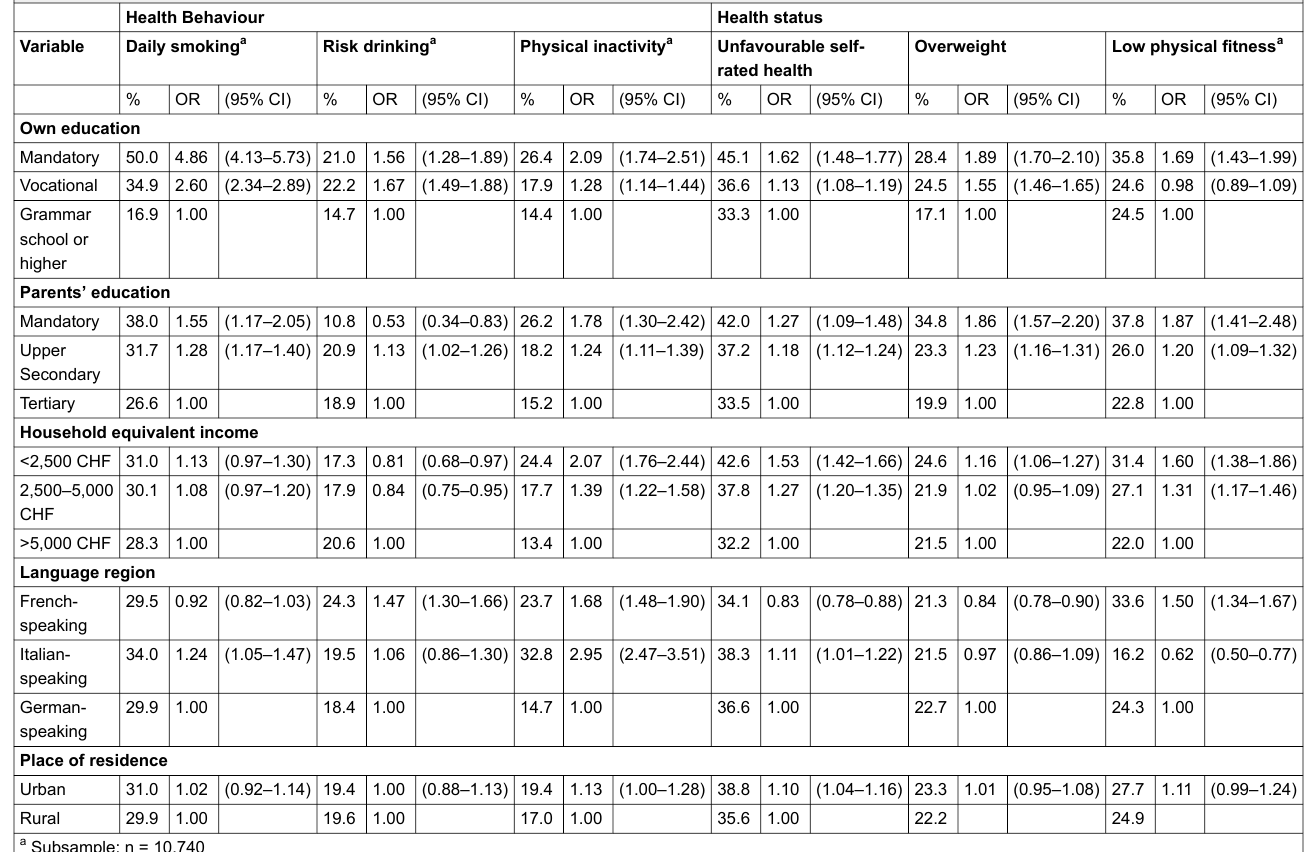
Table 2: Logistic parameter estimates for men (n = 31,424) with unfavourable health behaviour (daily smoking, alcohol risk consumption, physical inactivity) or unfavourable health status (overweight, low physical fitness, unfavourable self-rated health) as the dependent variable. Estimates are presented as age-adjusted odds ratios (ORs) and 95% confidence intervals